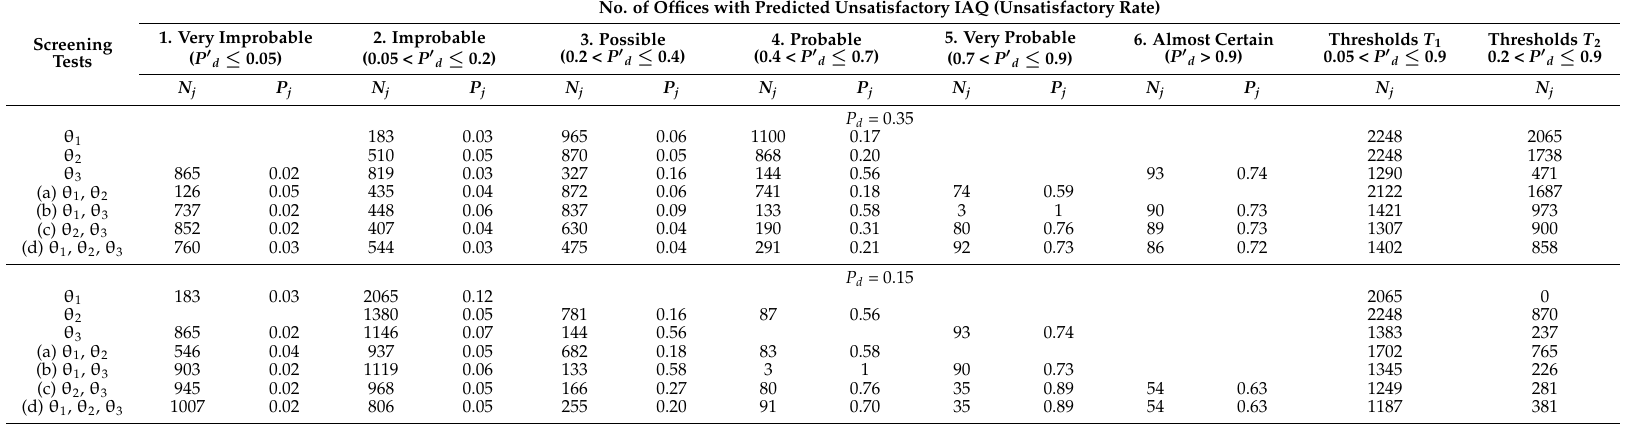
Table 4. IAQ classifications for 2248